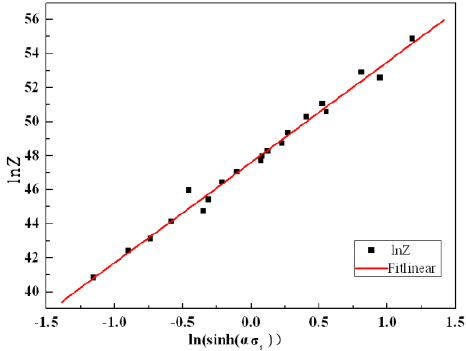
Figure 9. Z-parameter and peak stress fitting curve.